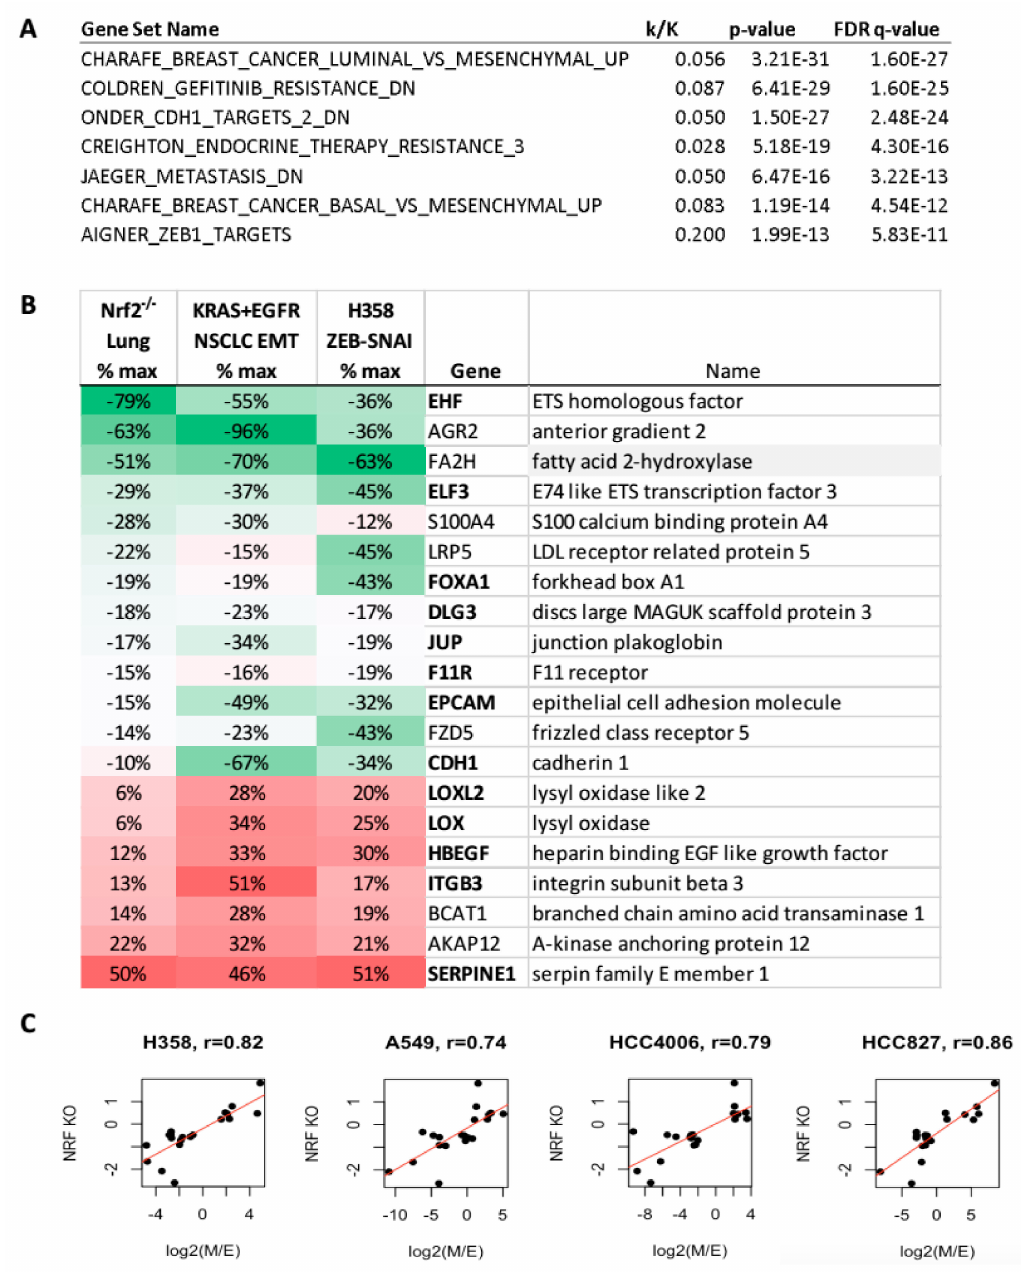
Figure 7. Mouse Nrf2 − / − promotes a mesenchymal phenotype in primary lung alveolar cells. ( A ) Gene set enrichment of Nrf2 KO RNA expression indicate correlation with multiple EMT signatures. ( B ) Lung alveolar cell RNA expression comparing Nrf2 knockout vs. control (column 1), is compared with mean log2 TGF β E and M state changes in the four lung adenocarcinoma cell models (column 2) and mean Zeb1 and Snail1 driven EMT changes in two H358 models. Data are expressed as percent maximum change to scale microarray and RNAseq dynamic ranges. EMT related RNAs are bolded. ( C ) Correlation of Nrf2 KO RNA expression with EMT RNA changes in the four NSCLC